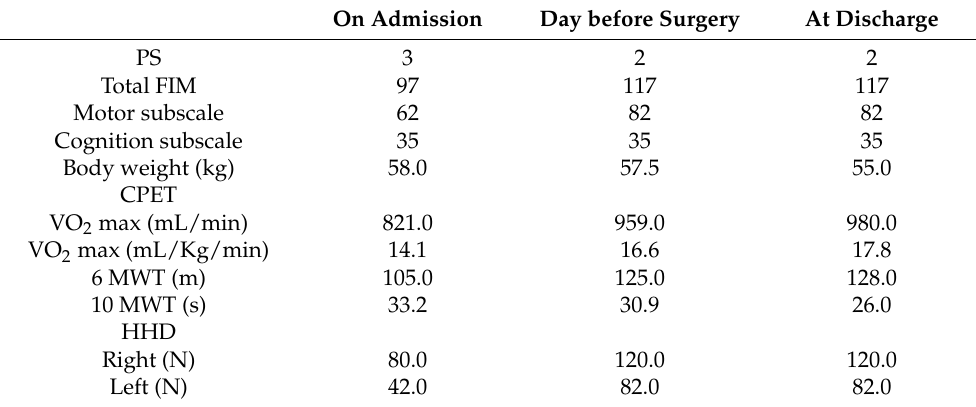
Table 2. Medical records of patients in the present case